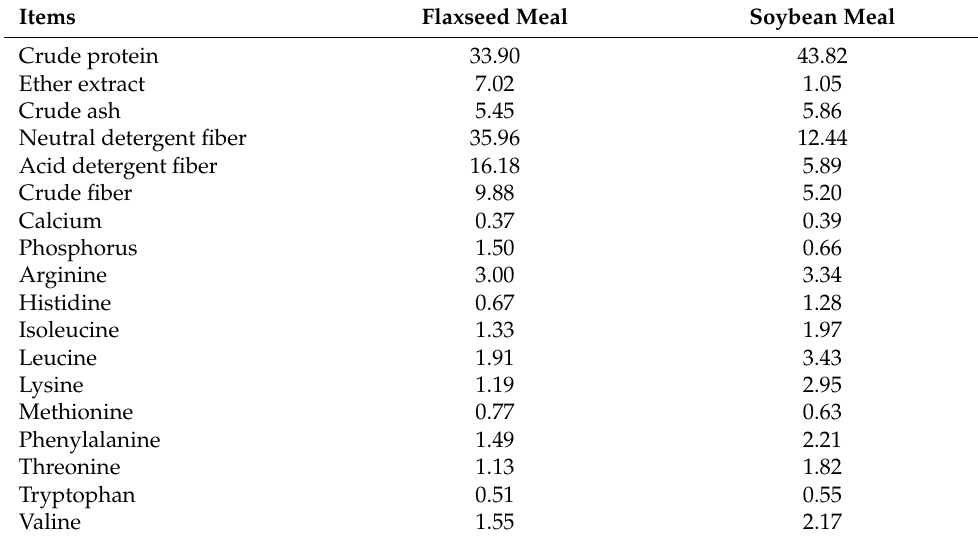
Table 1. The main nutritional composition of flaxseed meal and soybean meal (air dry basis,